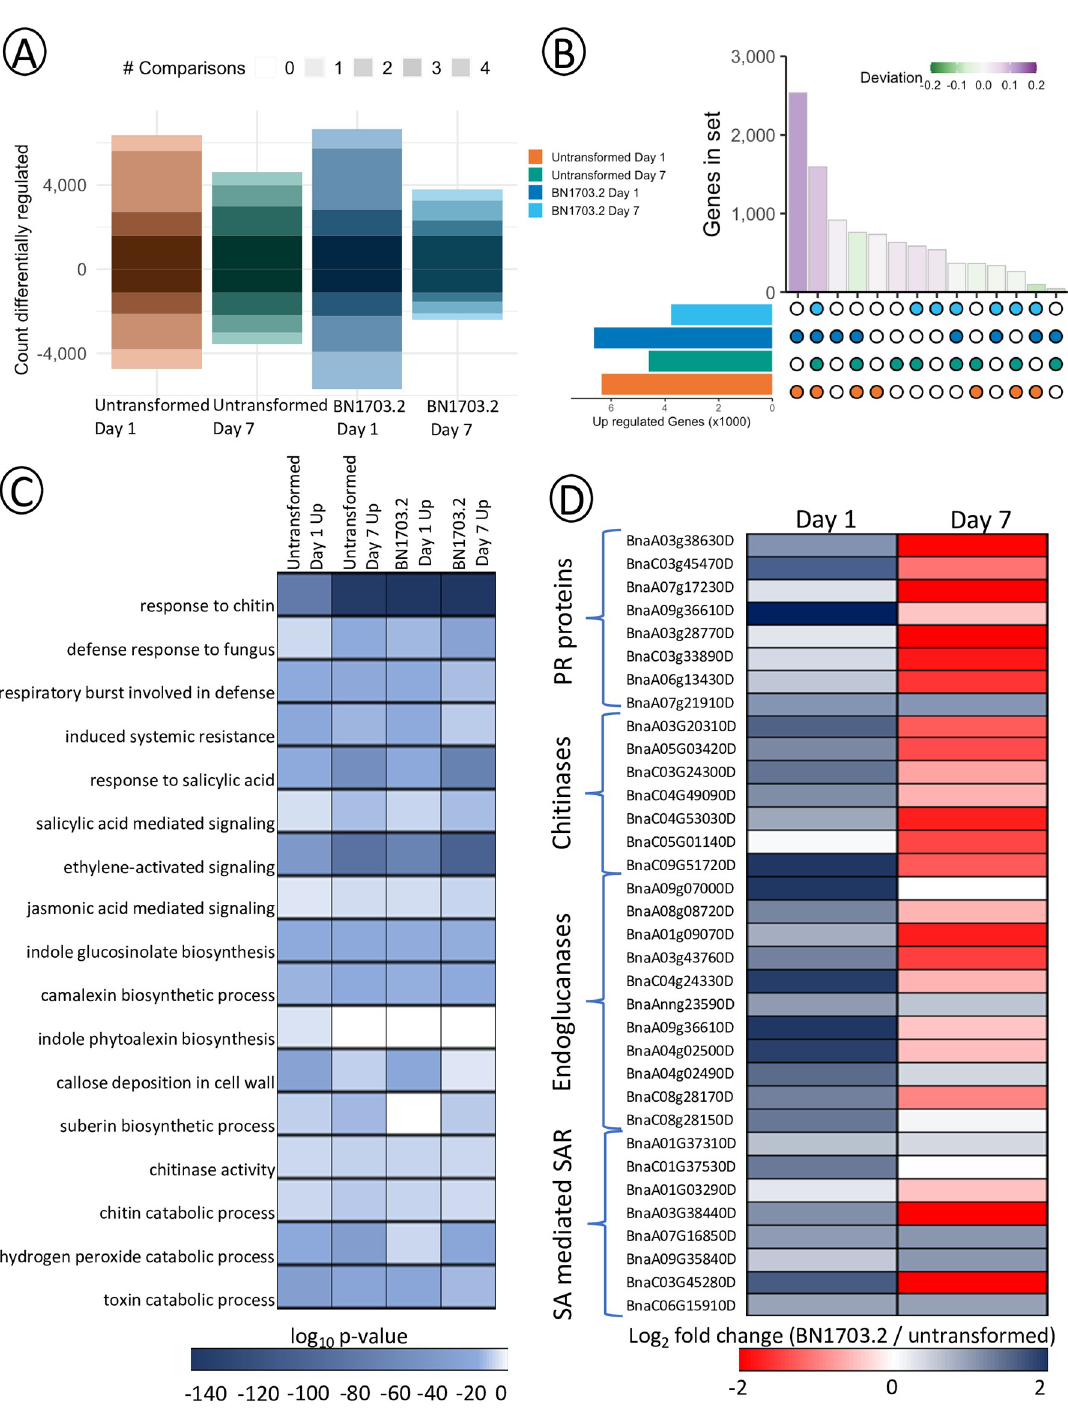
Fig 4. Transcriptomic characterization of plant defense to S . sclerotiorum in BN1703.2. (A) Stacked bar plot displaying the number of B . napus genes differentially expressed in untransformed and transgenic BN1703.2 infected stems 1 and 7 days post-inoculation and compared to the uninfected control (false discovery rate < 0.01). Darker shades of color represent higher numbers of patterns shared between treatments. (B) Upset diagram showing the sizes of gene sets induced by each combination of patterns. The bars for the set sizes are coloured by the deviation from the size predicted by random mixing. (C) Heatmap of significantly enriched GO terms of untransformed and BN1703.2 days 1 and 7 compared to uninfected from total DEG. GO terms are considered statistically significant if the hypergeometric P-value < 0.001. (D) Heatmap of a subset of genes encompassing significantly enriched GO terms within BN1703.2 during infection. GO terms are considered statistically significant if the hypergeometric P-value < 0.001.